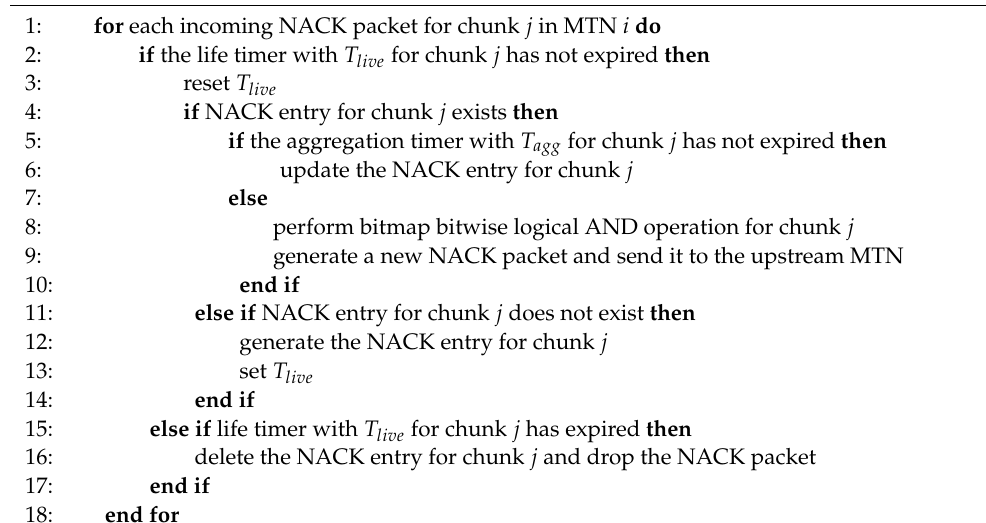
Algorithm 3 NACK Feedback Aggregation